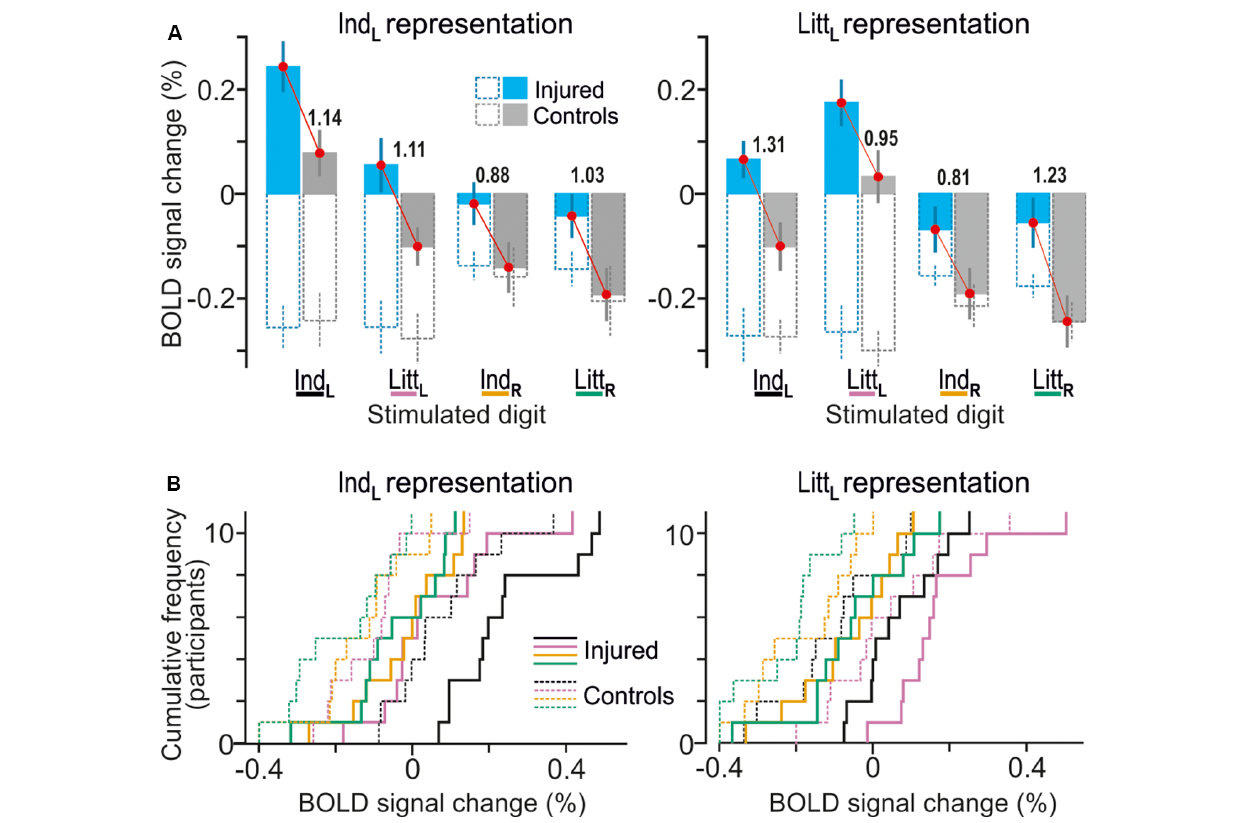
FIGURE 4 | Effects of injury on BOLD responses in fingertip representations in contralesional S1. (A) Paired neighboring columns show BOLD signal responses in the identified representations of the index finger (Ind L ; left panel) and little finger (Litt L ; right panel) representations when the left index (Ind L ), left little (Litt L ), right index (Ind R ) and right little (Litt R ) finger was stimulated. Filled columns show BOLD signal responses for the nerve-damaged (bluish) and control participants (gray) based on β -values averaged across all voxels within the respective finger representation and across both tactile tasks (column height indicate mean value across participants and vertical lines represent ± 1 SEM, N = 11). To highlight the systematically greater BOLD activity of the nerve-injured irrespective of stimulus conditions, red lines link the corresponding mean values of the injured and the control participants. The adjacent numbers give a standardized effect size for the difference between these mean values provided as Cohen’s d . Superimposed hollow dashed-line columns show the corresponding BOLD activity during the visual threshold tracking task for the nerve-injured (bluish) and controls (gray) upon stimulation of each of the four fingers. (B) Distribution of BOLD-signal changes across nerve-injured (solid lines) and control participants (dashed lines) during the tactile tasks based on the same data and following the color code for stimulated finger as indicated in panel (A)